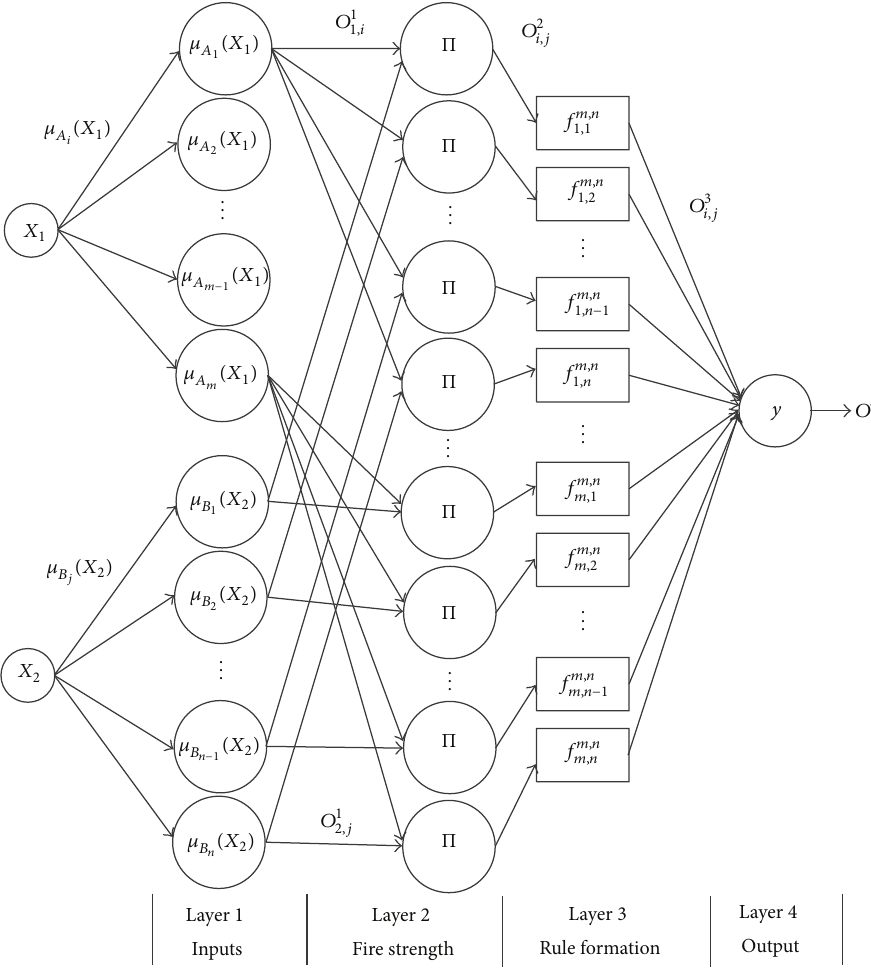
Figure 7: Architecture of adopted